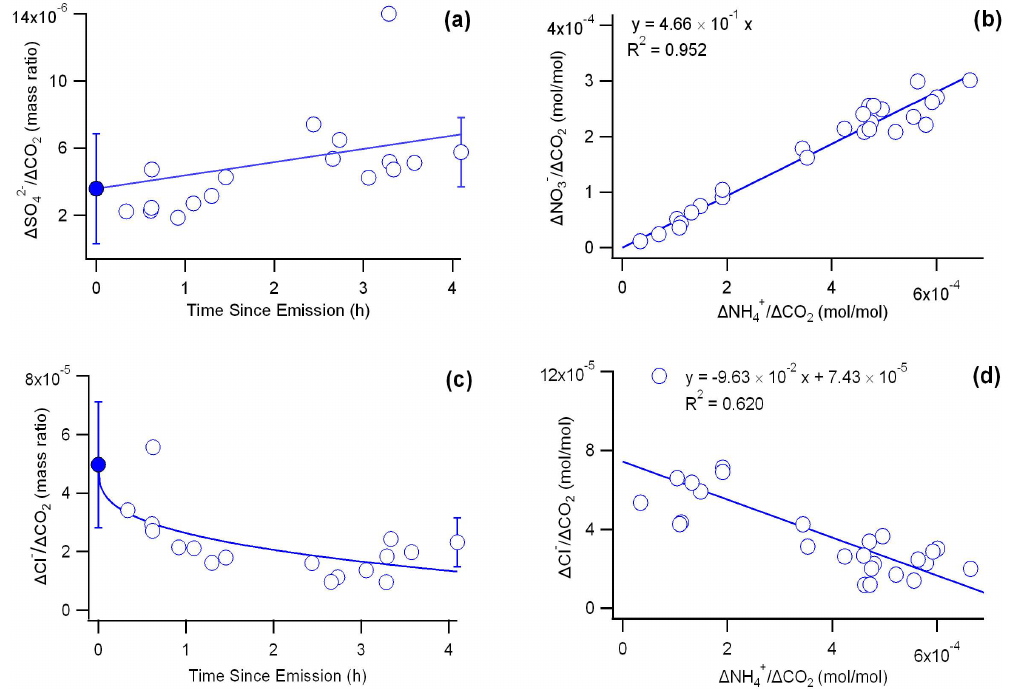
Fig. 10. (a) 1 SO 2 − / 1 CO 2 mass ratio vs. time since emission (h). (b) 1 NO − 4 mass ratio vs. time since emission (h) fit to a power curve. (d) 1 Cl − / 1 CO 2 vs. 1 NH + source samples are not shown and we instead show ERs (solid circles) with an error bar that is the standard deviation in the mean of the ten source measurements. Downwind error bars are an estimate of the uncertainty in oldest individual downwind